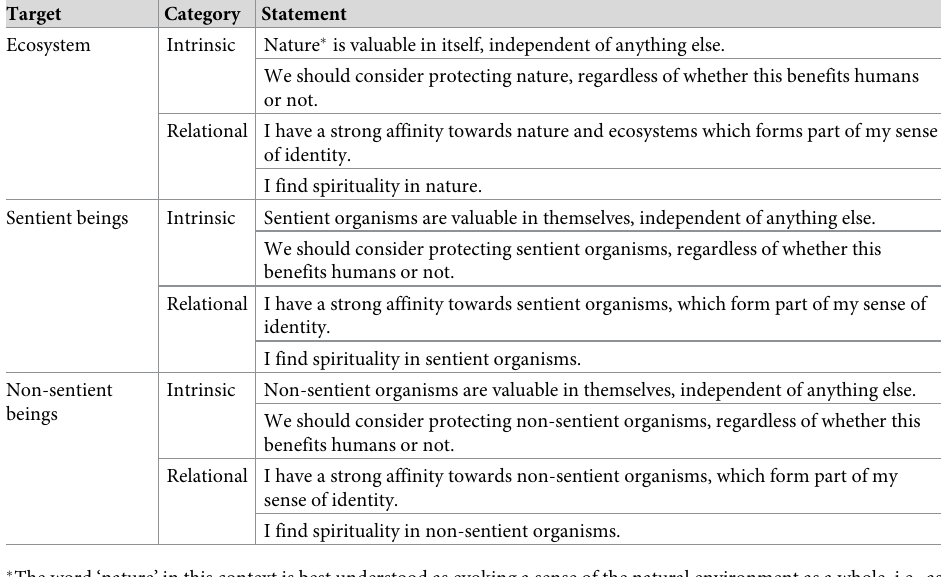
Table 1. Value statements used in the